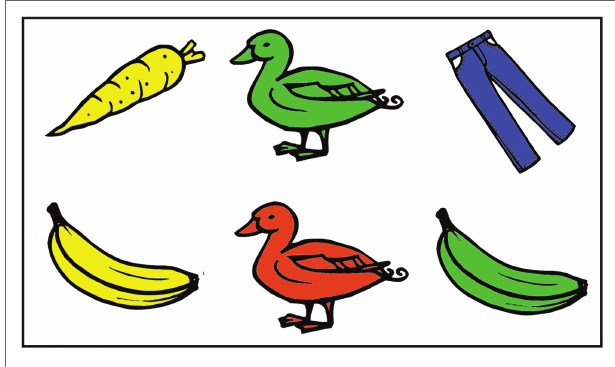
FIGURE 1 | Sample experimental display. Objects pictured were adapted from materials by Saskia, Gast, and Janina Valko and are available at madoo. net under a (cc) Creative Commons by-sa license.